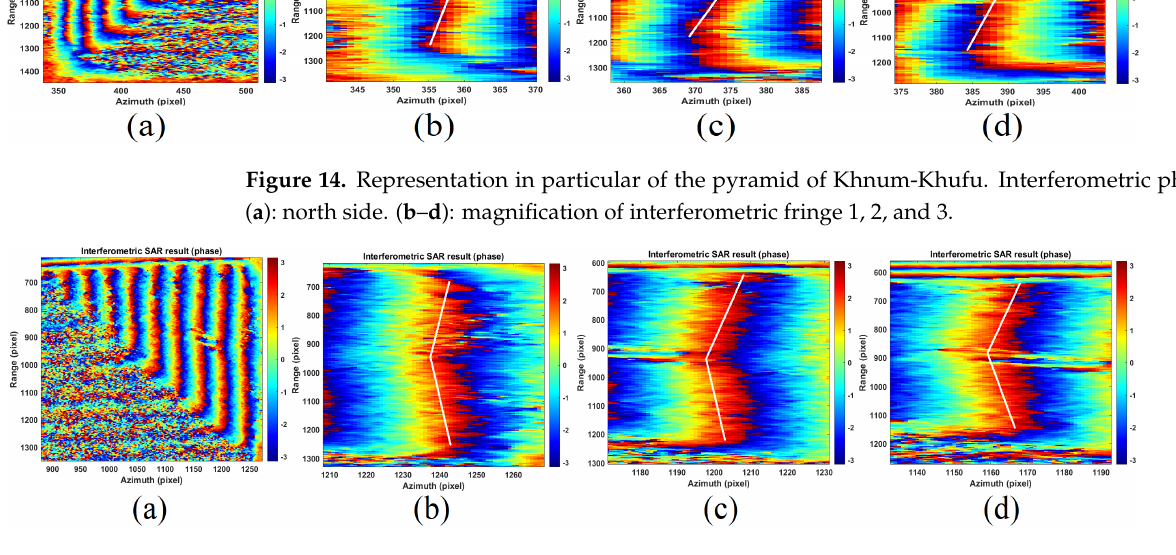
Figure 15. Representation in particular of the pyramid of Khnum-Khufu. Interferometric phases. ( a ): south side. ( b – d ): magnification of interferometric fringe 1, 2, and